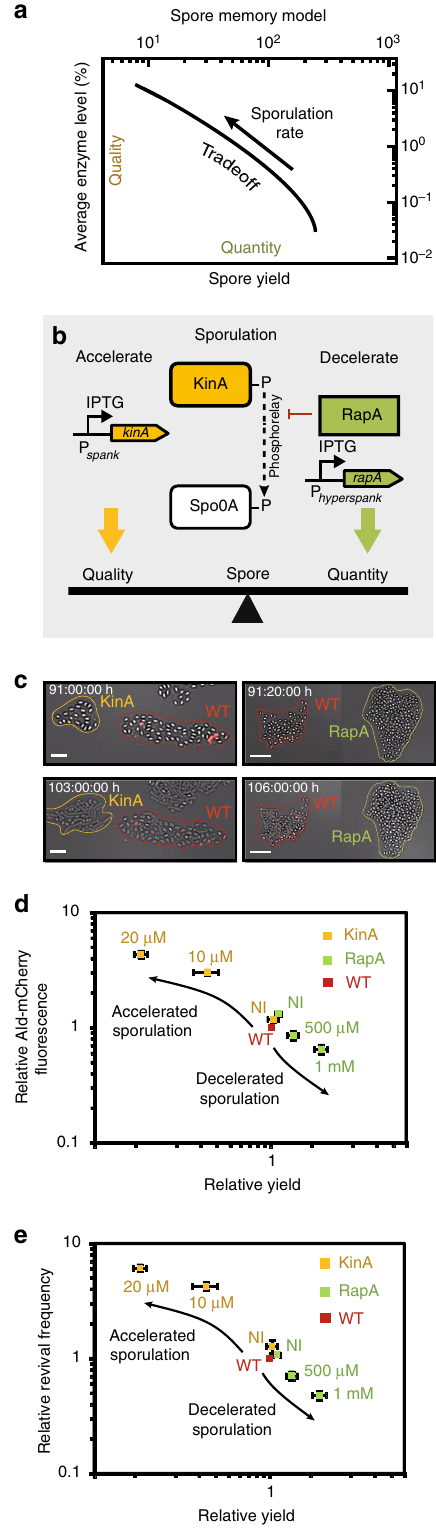
Fig. 10 Spore memory creates a quantity vs. quality tradeoff. a Results from a mathematical model showing a tradeoff between increasing spore yields (quantity) and decreasing average enzyme level per spore (quality) that emerges from memory. b To tip the balance between spore quantity and quality, KinA (RapA) was expressed from an IPTG-inducible promoter to accelerate (decelerate) sporulation. c Snapshots of kinA (BIB1334) and rapA (BIB1330) mutant colonies, that were co-cultured with a WT reporter strain (BIB1126). Images show spore colonies before (top) and after stimulation with L -alanine (bottom). Scale bar: 10 µ m. d Fluorescence from Ald- mCherry vs. spore yield and e spore outgrowth vs. spore yield. Sporulation timing was modulated by the varying the IPTG levels in kinA ( rapA ) mutants. All values are normalized to the WT that was grown in co-culture in each case. Strains: WT (BIB1423), kinA (BIB1440), rapA (BIB1442), data: mean ± SEM, n c ≥ 5 ( n s ≥